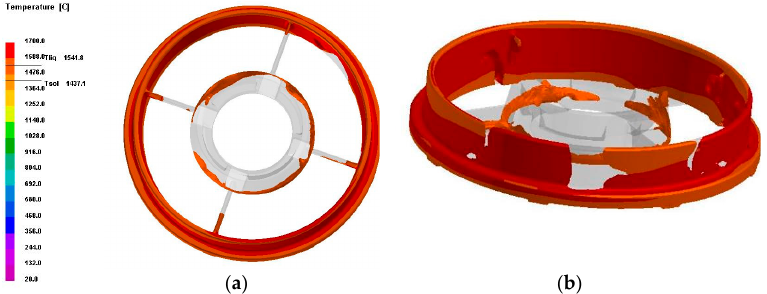
Figure 4. Melt mold filling temperature field in the centrifugal force field. The filling behaviour of the melt liquid in four support plates was different. In ( a ), the filling time of the metal liquid in 4 support plates were different. The melt liquid in one support plate has filled into one half while the melt has not filled the other plate. In ( b ), the filling in the outer ring was not synchronised: the outer ring on the preferable side was almost filled while there was still a large area that had not been filled on the other side. other